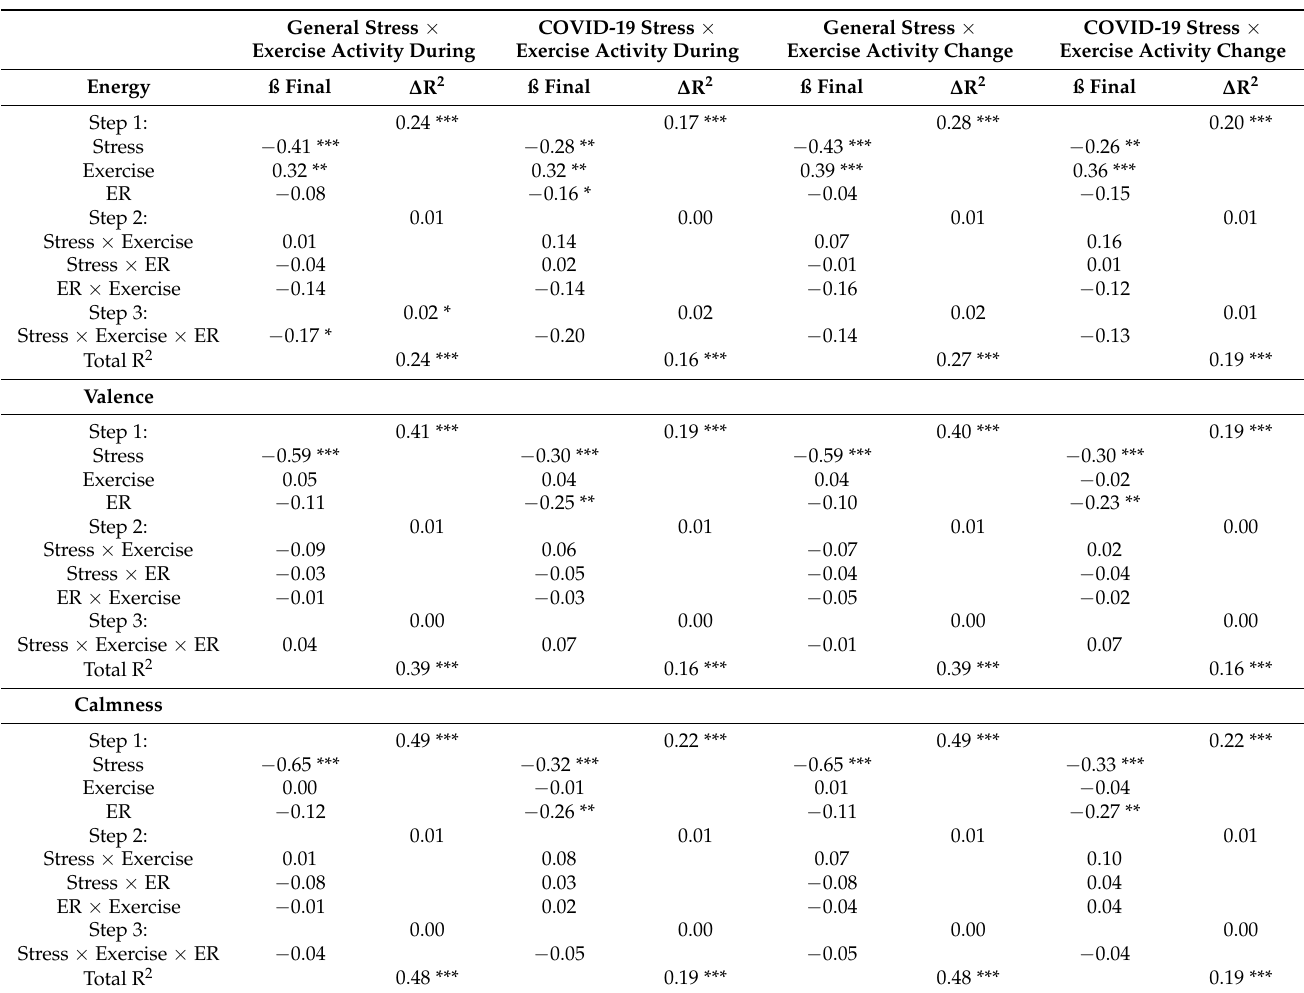
Table 5. Hierarchical Regression Results for Mood Among